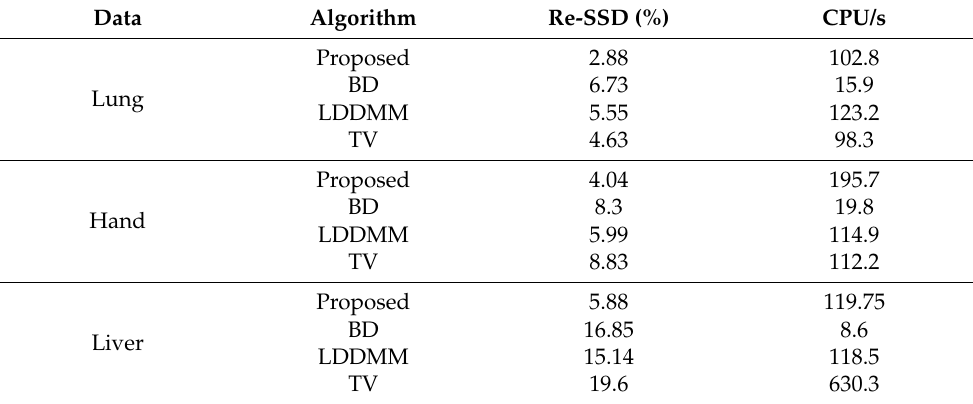
Figure 10. Registration result for different scales on image pairs Liver. ( a ) T ( · ) . ( b ) Re − SSD = 25.59%. ( c ) Re − SSD = 10.53%. ( d ) Re − SSD = 6.63%. ( e ) Re − SSD = 5.99%. ( f ) Re − SSD = 5.88%. Table 2. Quantitative comparison of registration results of four different algorithms (test for medical image